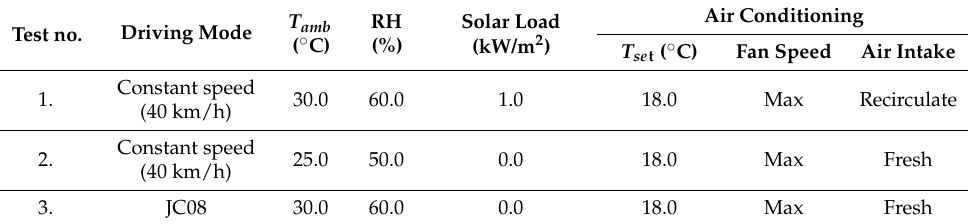
Table 7. The experimental conditions for the vehicle wind tunnel test.